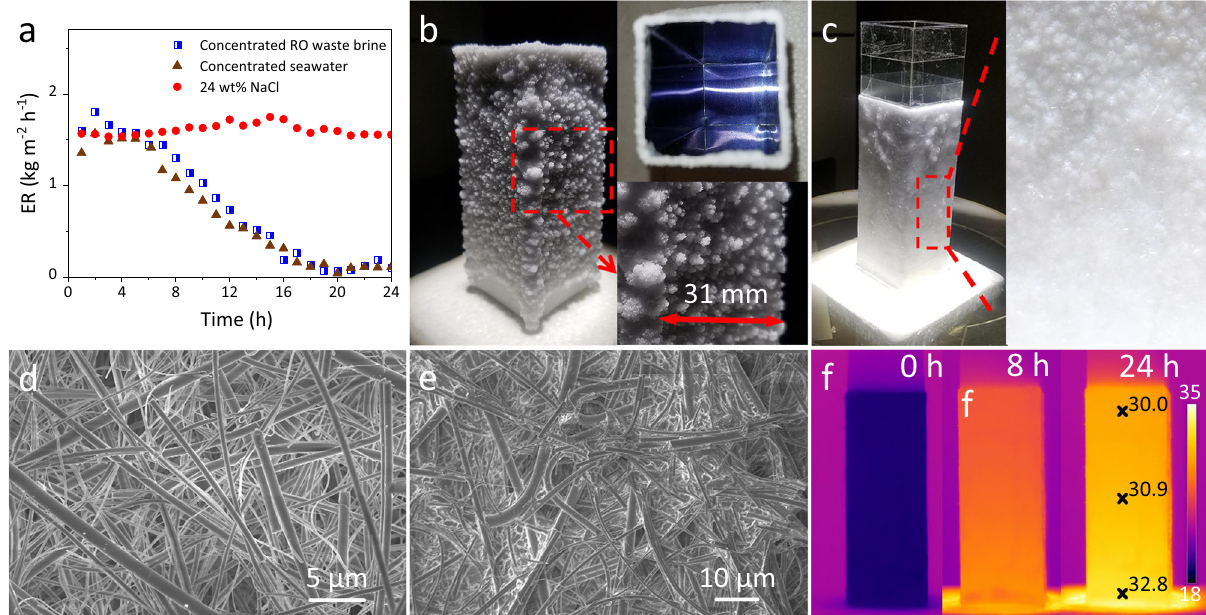
Fig. 3 Solar evaporation and crystallization behavior of brines. a The evaporation rate (ER) of 24 wt% NaCl brine and real seawater brines in the 24-h operation; photos of the solar crystallizers after the 24-h operation using b 24 wt% NaCl brine and c concentrated RO waste brine; SEM images of the inner side of QGF membrane after operating with d 24 wt% NaCl brine and e concentrated real RO waste brine; f the IR images of the solar crystallizer while treating concentrated RO waste brine. Note: In Fig. 3c, an optional transparent polycarbonate shield with a height of 30 mm was added to the solar crystallizer in order to prevent salt crystal from creeping into the inner side of the